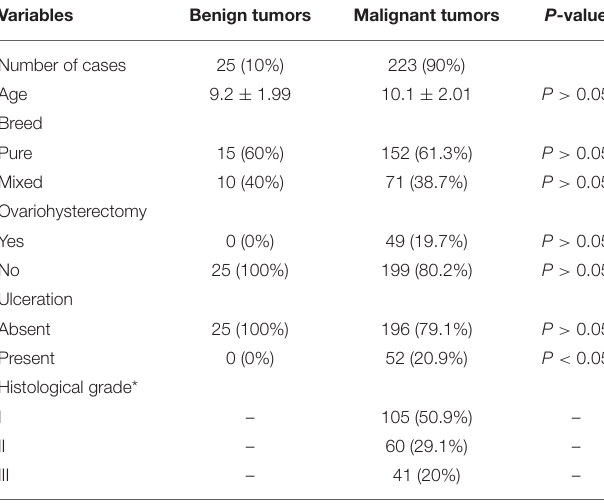
TABLE 1 | Clinical parameters of the 248 dogs used in this